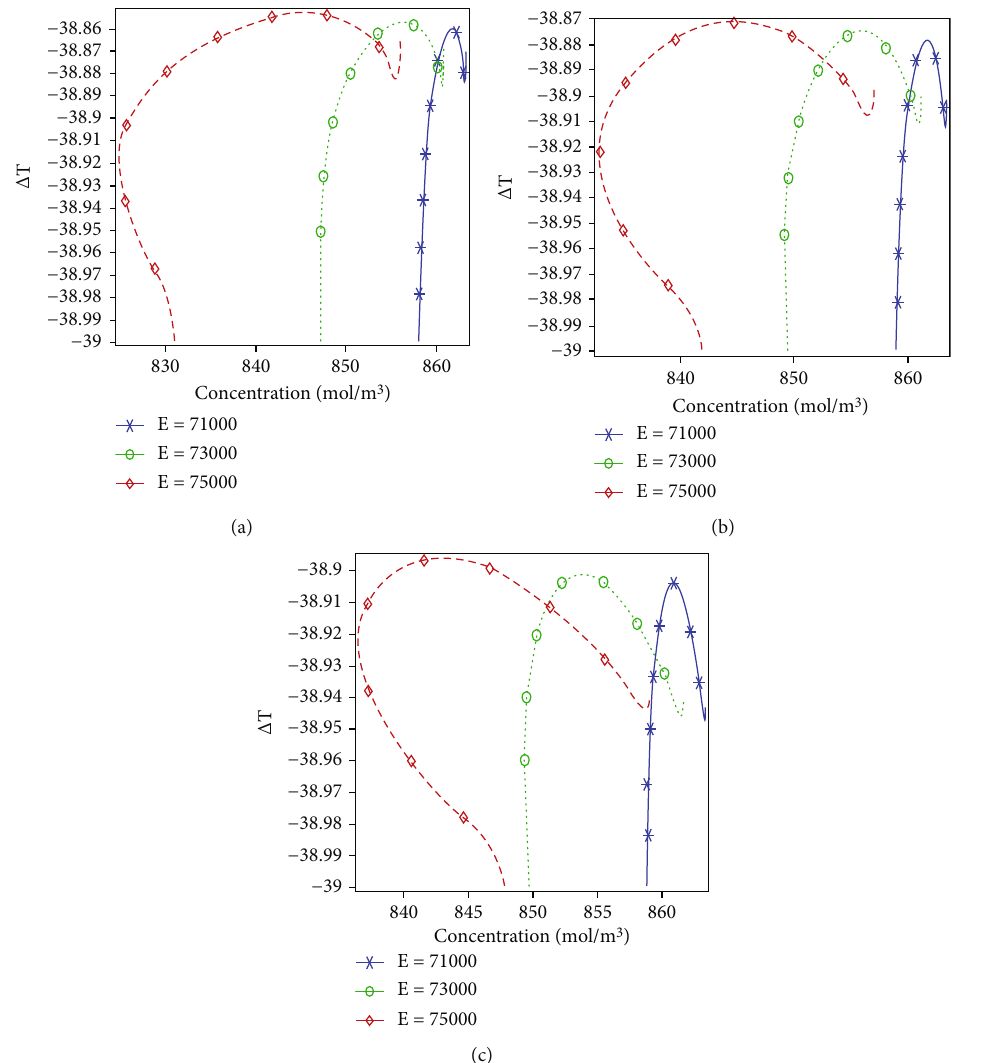
Figure 10: Change in the temperature at downstream along the backward step channel against the concentration of calcium hydroxide at (a) Re = 100 , I : C = 2 % , a = 0 : 5 ; (b) Re = 100 , I : C = 2 % , a = 0 : 6 ; and (c) Re = 100 , I : C = 2 % , a = 0 : 7